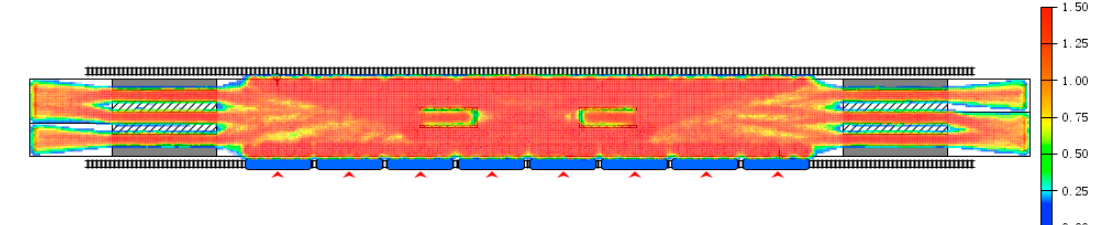
Figure 19. Train parking interface.